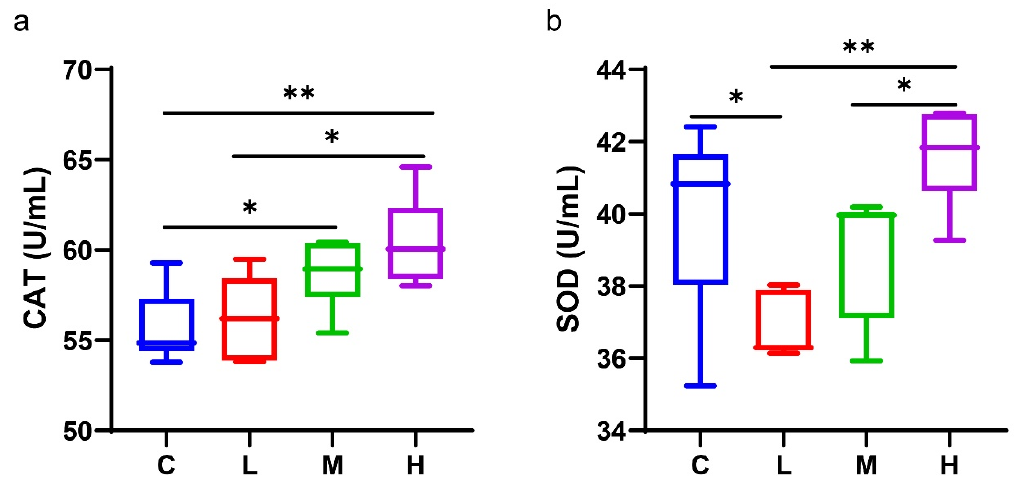
Figure 7. CFJ improved antioxidant ability in vivo. The activity of catalase (CAT) ( a ) and superoxide dismutase (SOD) in serum ( b ). * p < 0.05 and ** p < 0.01.